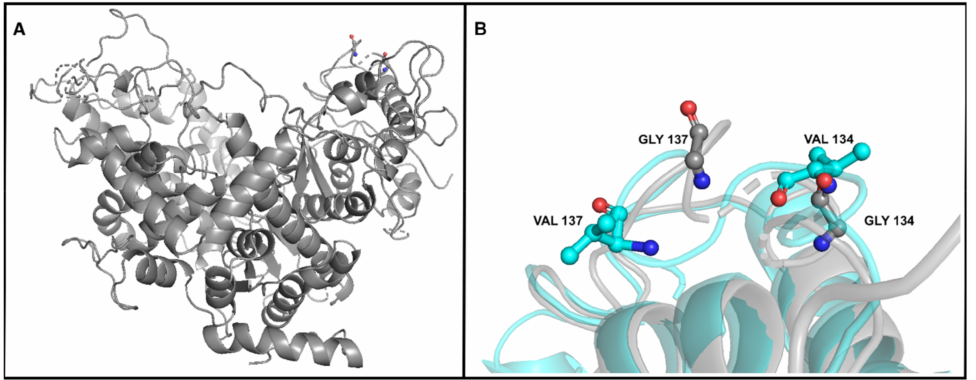
Figure 4. The predicted structure of the DNA polymerase A constructed using Phyre2 [44]. ( A ) The whole structure of the protein; Glycines 134 and 137 can be seen in the upper right corner. ( B ) Focus on amino acids 134 and 137. Grey: the structure with Glycines; Cyan: the structure with